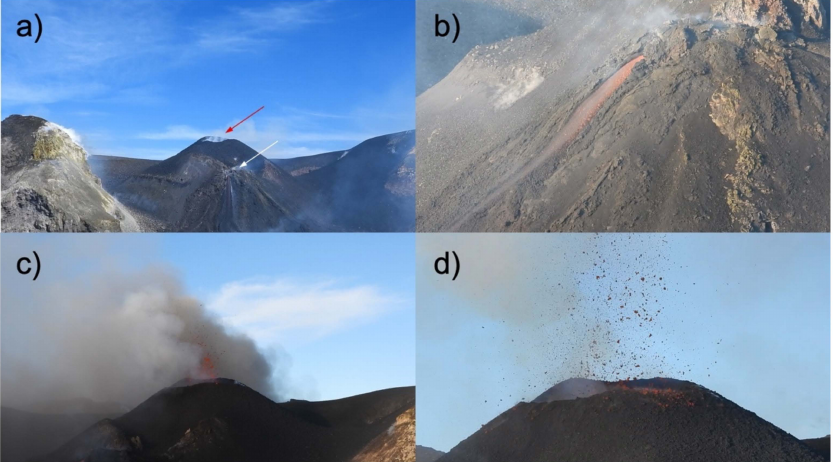
Figure 3. Shaded relief of Etna summit ( a ) on the 4th of July 2017 ( b ) during the survey (25 February 2020) and ( c ) difference in m between the 2020 and 2017 DEMs. The given colors of the legend represent the ranges of thickness values in m of the volcanic products, both lava flow and tephra.